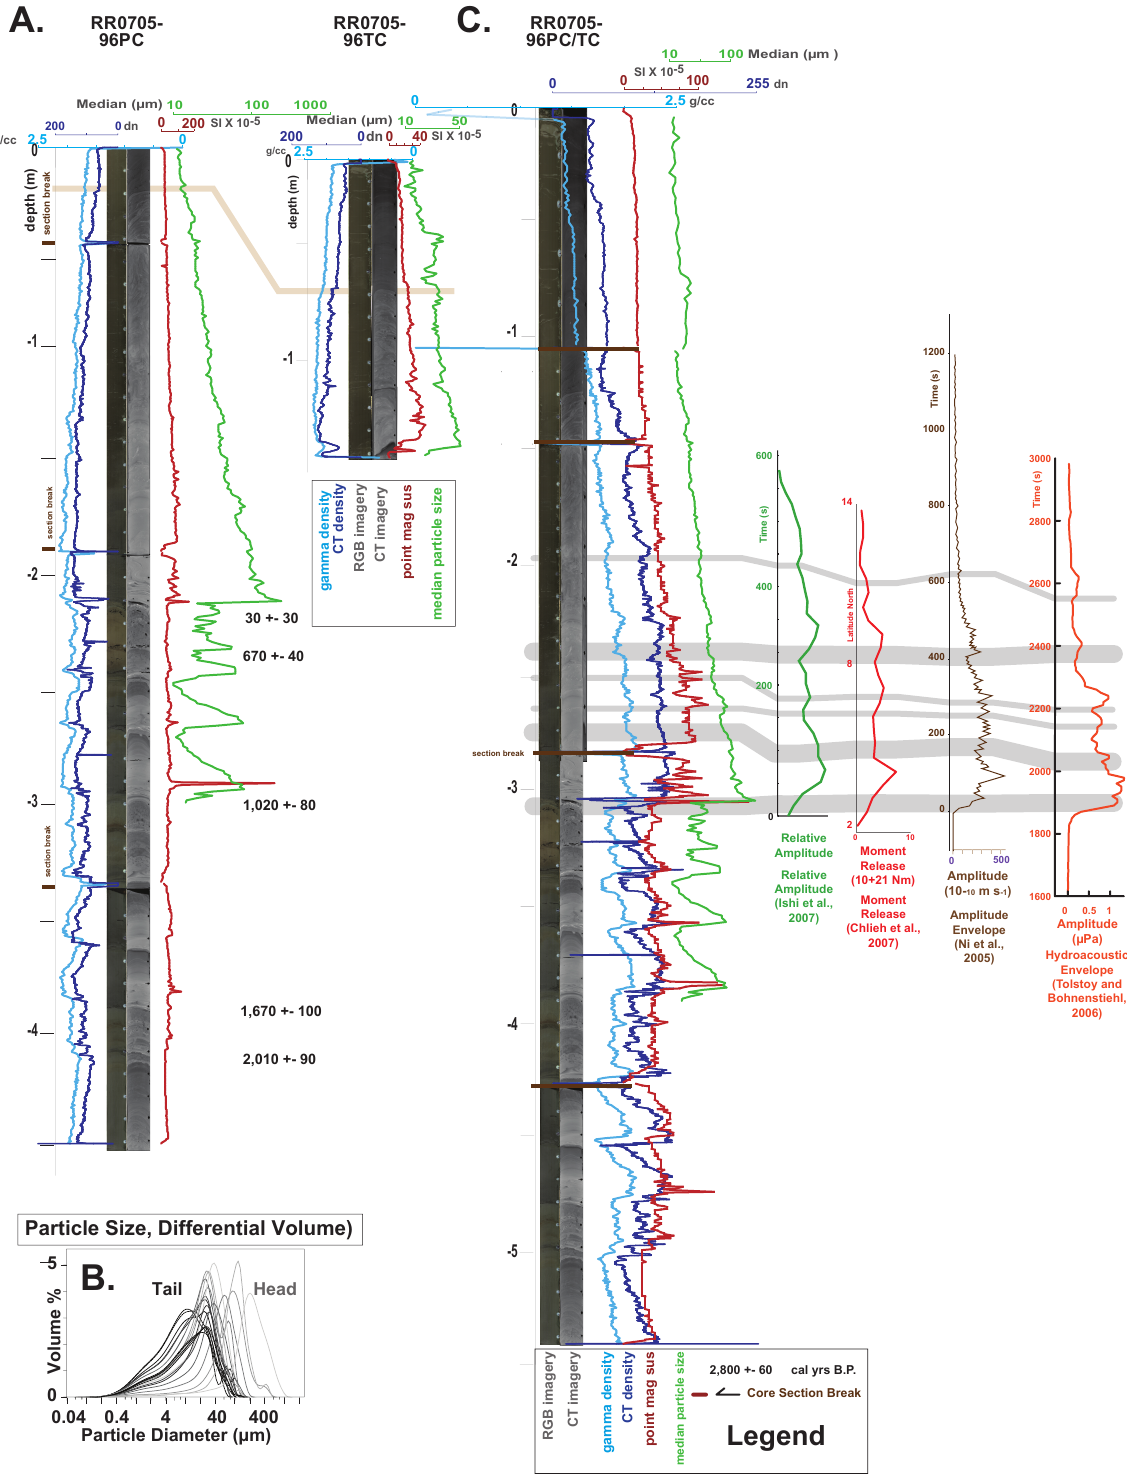
Fig. 6. Sumatra slope basin cores with an expanded Holocene section (Fig. 3). (A) RR0705-96PC is plotted with the same configuration as Fig. 2. Median grain size data are plotted in green with 1cm spacing. (B) Particle size distribution data from sample locations at 10cm spacing found in (A) are plotted by volume (%) vs. particle size (µm, log scale) with lines generally designating samples’ depth where the lighter lines have a larger mean size and are generally lower in section. Differential volume displays the percent volume of each particle size. (C) Core 96TC is scaled to 96PC and graphically spliced above 96PC to generate this composite core 96PC/TC. Moment release (vs. latitude) in red (Chlieh et al., 2007) and relative amplitude (vs. time) in green (Ishii et al., 2007), brown (Ni et al., 2005), and orange (Tolstoy and Bohnenstiehl, 2006) are scaled to match peaks in the loop ms data from composite core RR0705-96PC/TC. Thick grey tie lines correlate the beginning of seismic peaks with each other and with base of peaks in the core geophysical data. Thin grey lines show secondary correlations (lower seismic energy and lower amplitude core geophysical